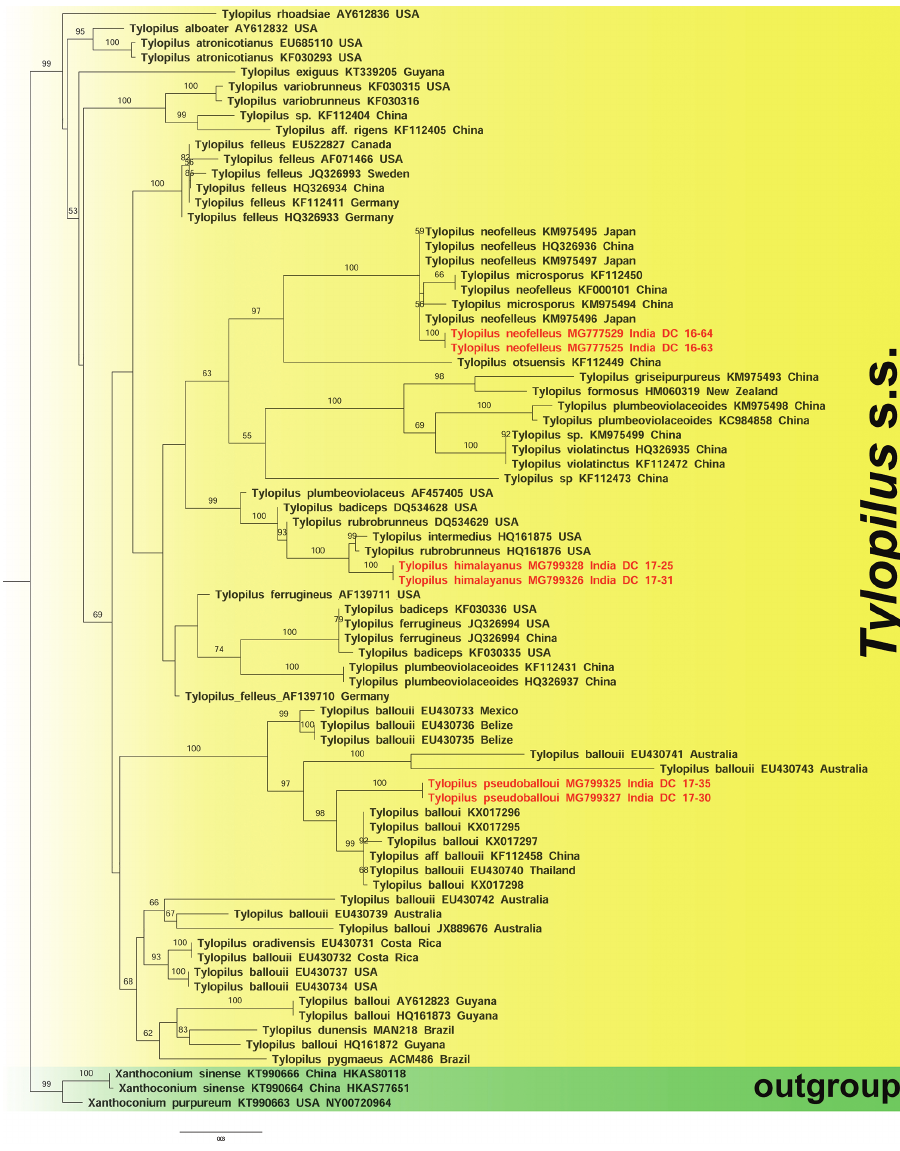
Figure 1. nrLSU based phylogram generated from Maximum likelihood (ML) analysis under GTR- GAMMA substitution model depicting the placement of Tylopilus neofelleus, T. pseudoballoui and T. hima- layanus within Tylopilus s.s. Two species of Xanthoconium ( X. sinense and X. purpureum ) were used as outgroup taxa. ML Bootstrap percentage (MLB) derived from this analysis (MLB >50%) are shown above or beneath the branches. Two novel species and a new record for Indian mycobiota are highlighted in bold and red font. GenBank accession no. and country name (when available) for each species are shown after the species